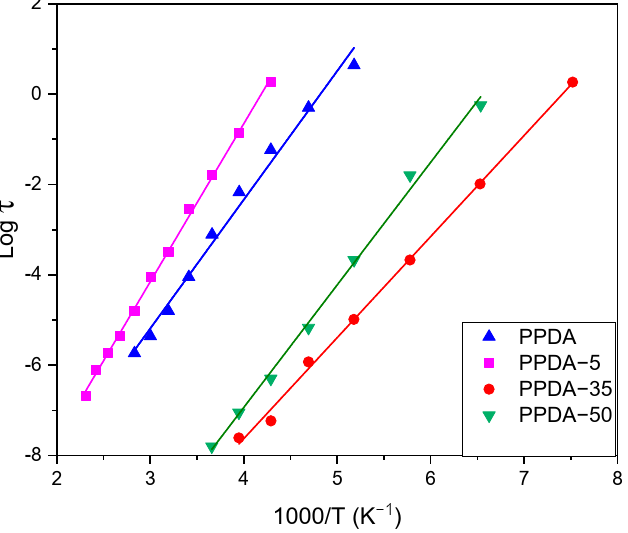
Figure 9. Plot of relaxation time vs. reciprocal temperature for PPDA and PPDA/MMT composites.